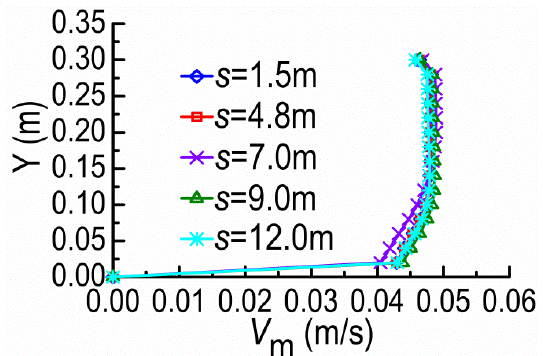
Figure 10. V m along Y-direction at the tip vicinity of SD1.